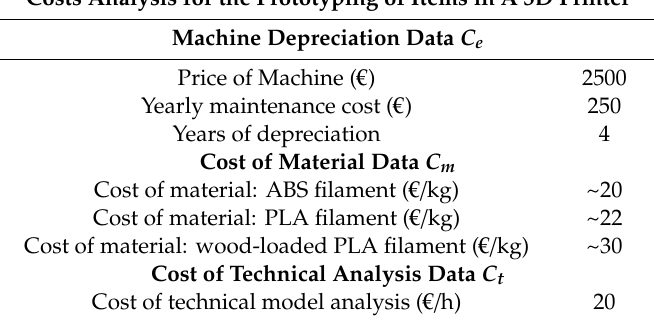
Table 2. Costs of rigid parts for the manufacturing process.